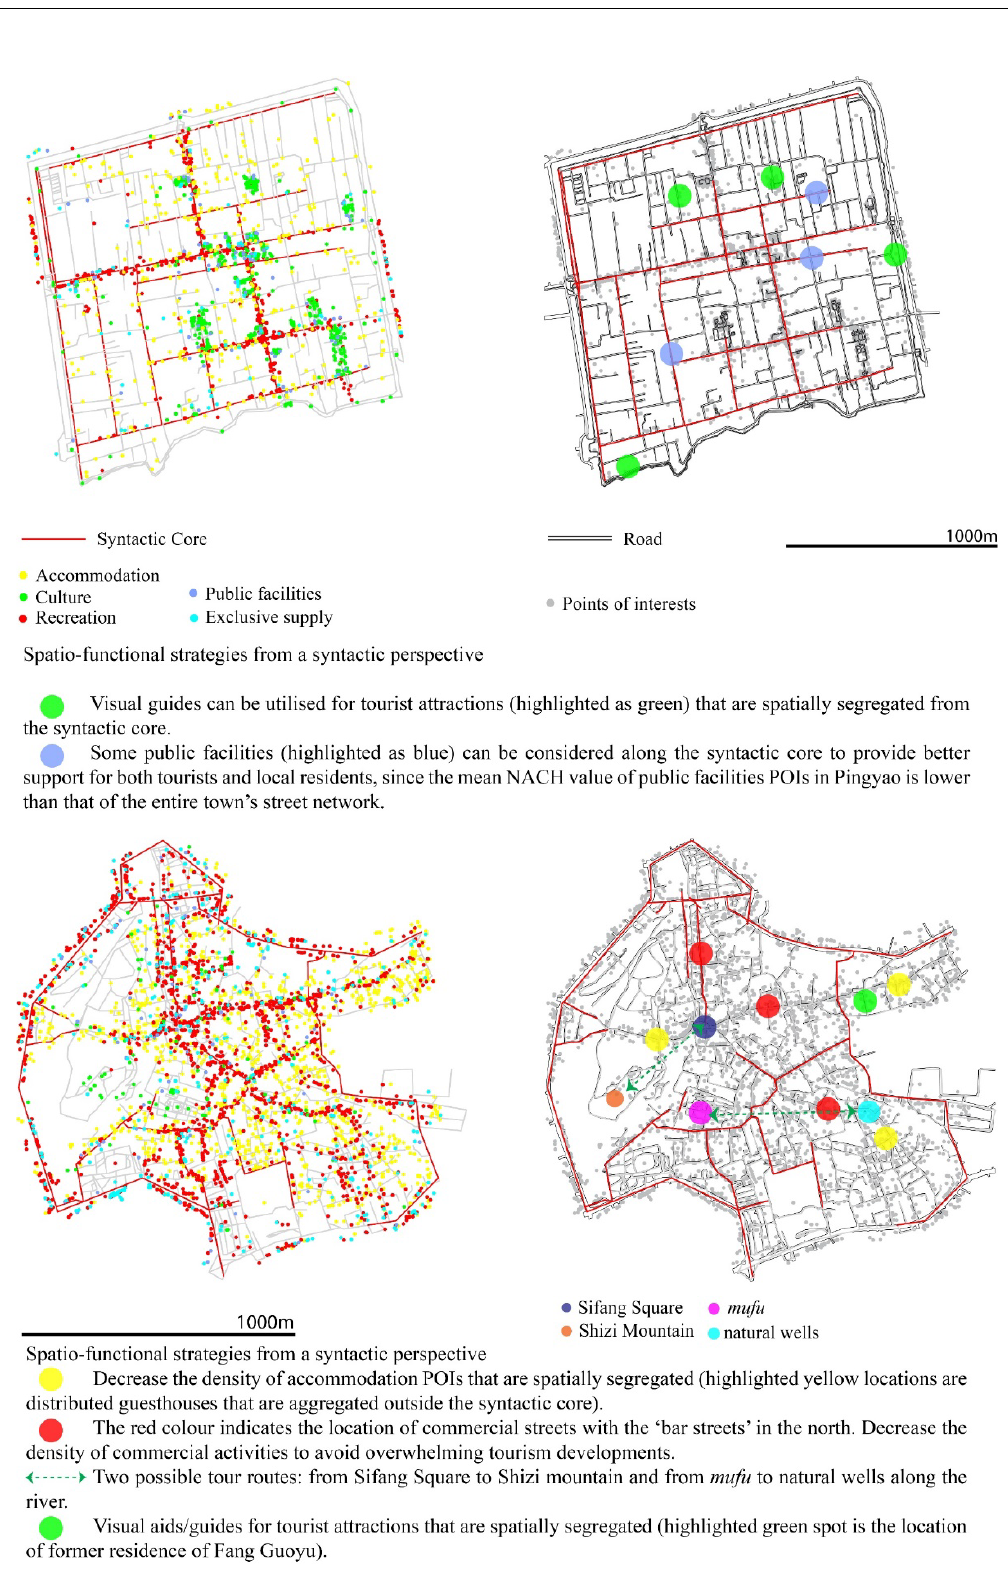
Figure 14. The strategies suggested for Pingyao and Lijiang based on the spatio-functional analysis results.